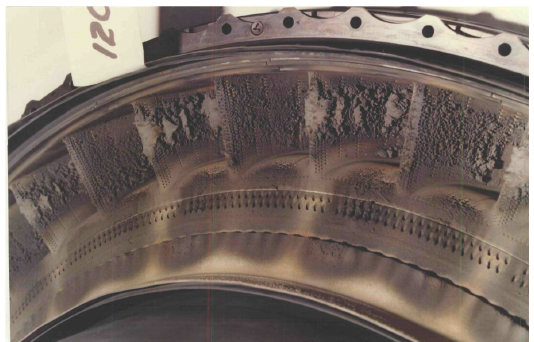
Figure 1. Deposited volcanic ash on the high pressure turbine nozzle guide vanes of a Rolls-Royce RB211-524C engine involved in an encounter with the volcanic ash plume from the 1982 eruption of Mount Galunggung in Indonesia